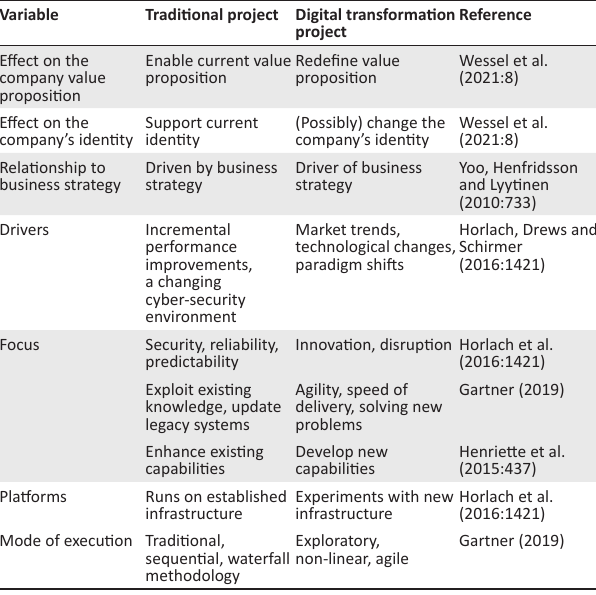
TABLE 1 : Differences between traditional projects and digital transformation. Variable Traditional project Digital transformation project